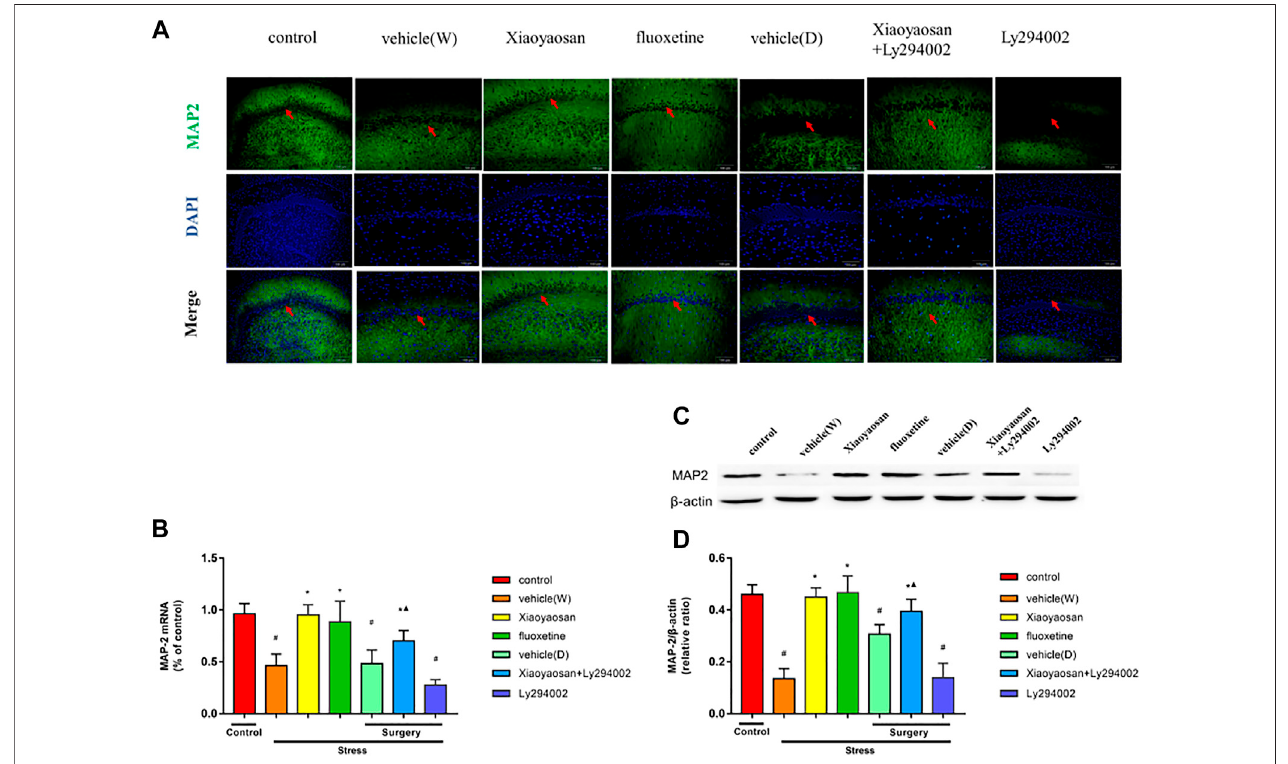
FIGURE 5 | Xiaoyaosan elevates the expression of MAP2 in the hippocampal CA1 region of CUMS rats ( A , original magni fifi cation, × 200) Xiaoyaosan and Xiaoyaosan + Ly294002 promoted MAP2 expression in the CUMS rats. The green color represents MAP2 staining, and the blue color represents nuclear staining (C) Representative images and western blot analysis (D) of western blot assay showing the relative expression of MAP2 (B) Level of MAP2 mRNA in the hippocampal CA1areaoftheratsinthetreatmentandcontrolgroups.Alldataareexpressedasthemean ± SD. # p < 0.05comparedtothecontrolgroup;* p < 0.05comparedto the vehicle (W) group; ▲ p < 0.05 compared to the Ly294002 group, n (cid:2)